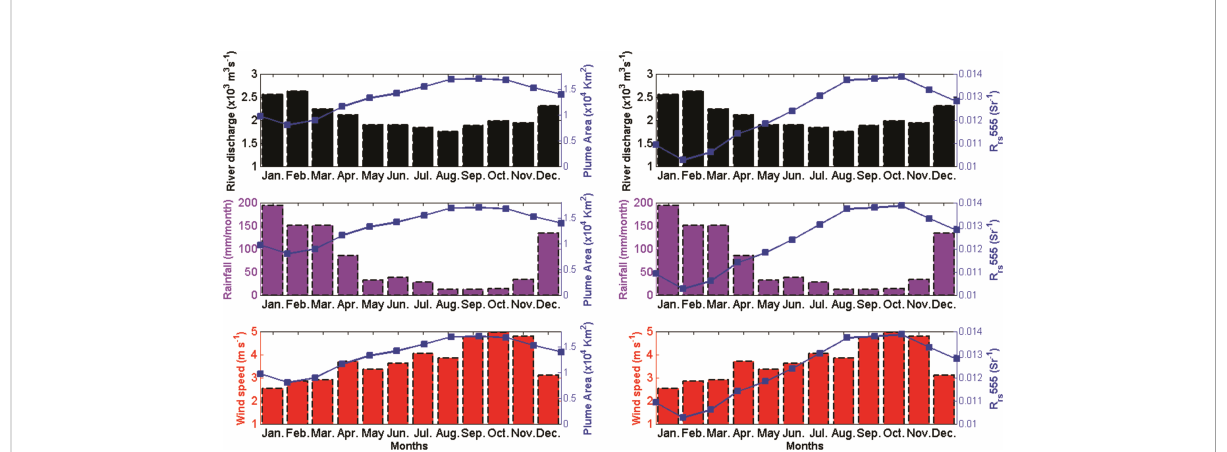
FIGURE 5 Overlap of the climatology of annual variation of the Zambezi River discharge with plume area and R rs 555 (upper), rainfall with plume area and R rs 555 (middle), and wind speed with plume area and R rs 555 (lower) for the 2003 – 2016 period. The monthly mean R rs 555 used to compute the seasonal climatology was extracted from the mean plume area estimated through linear regression.